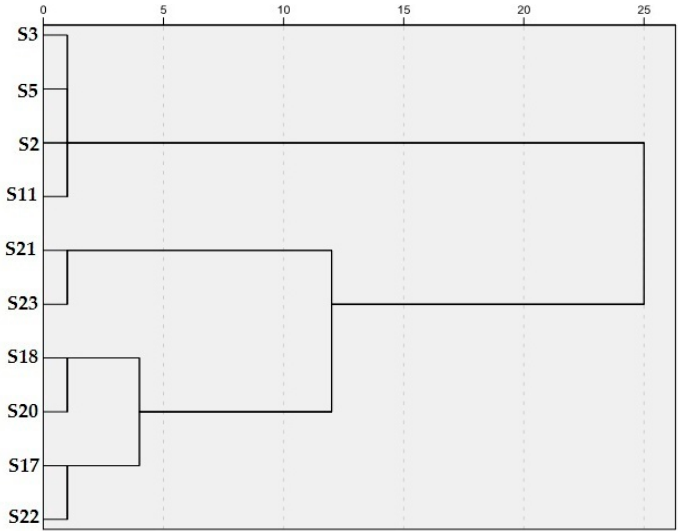
Figure 2. Similarity dendrogram of globe artichoke clones based on an agglomerative hierarchical cluster analysis of the morphological data listed in Table 1. The axis reports the Rescaled Distance Cluster Combine, as from the SPSS output.